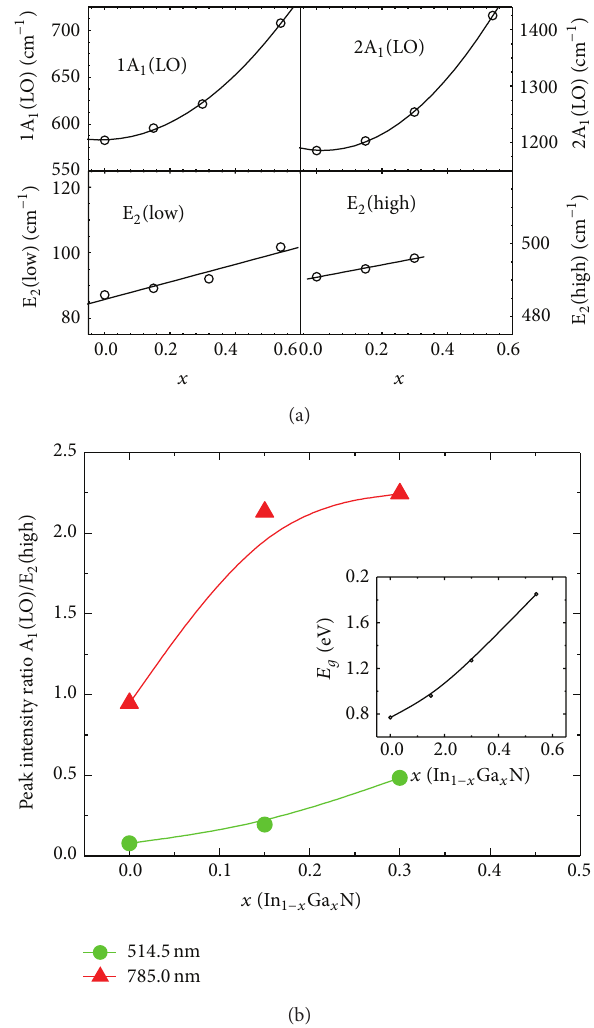
Figure 3: (a) Energy variations of 1A 1 (LO), 2A 1 (LO), E 2 (Low), and E 2 (high) modes with respect to Ga atomic fraction in In 1−𝑥 Ga 𝑥 N alloy thin films. (b) Variation in the ratio of A 1 (LO)/E 2 (high) with respect to Ga atomic fraction for In 1−𝑥 Ga 𝑥 N alloy thin films for red and green lasers (Colored online), inset showing bandgap variation with respect to Ga atomic fraction for In 1−𝑥 Ga 𝑥 N alloy thin